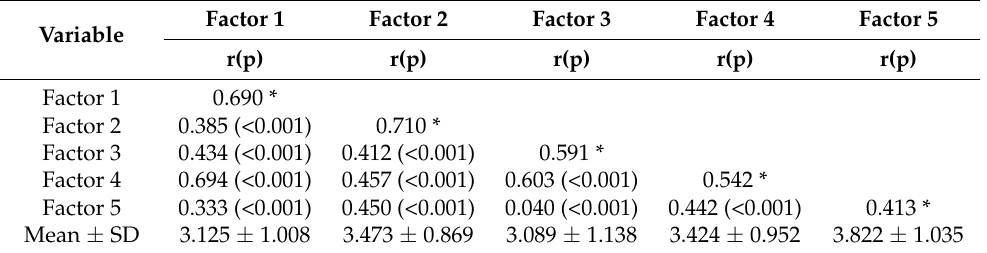
Table 4. Discriminant validity in the confirmatory factor analysis ( N = 248).